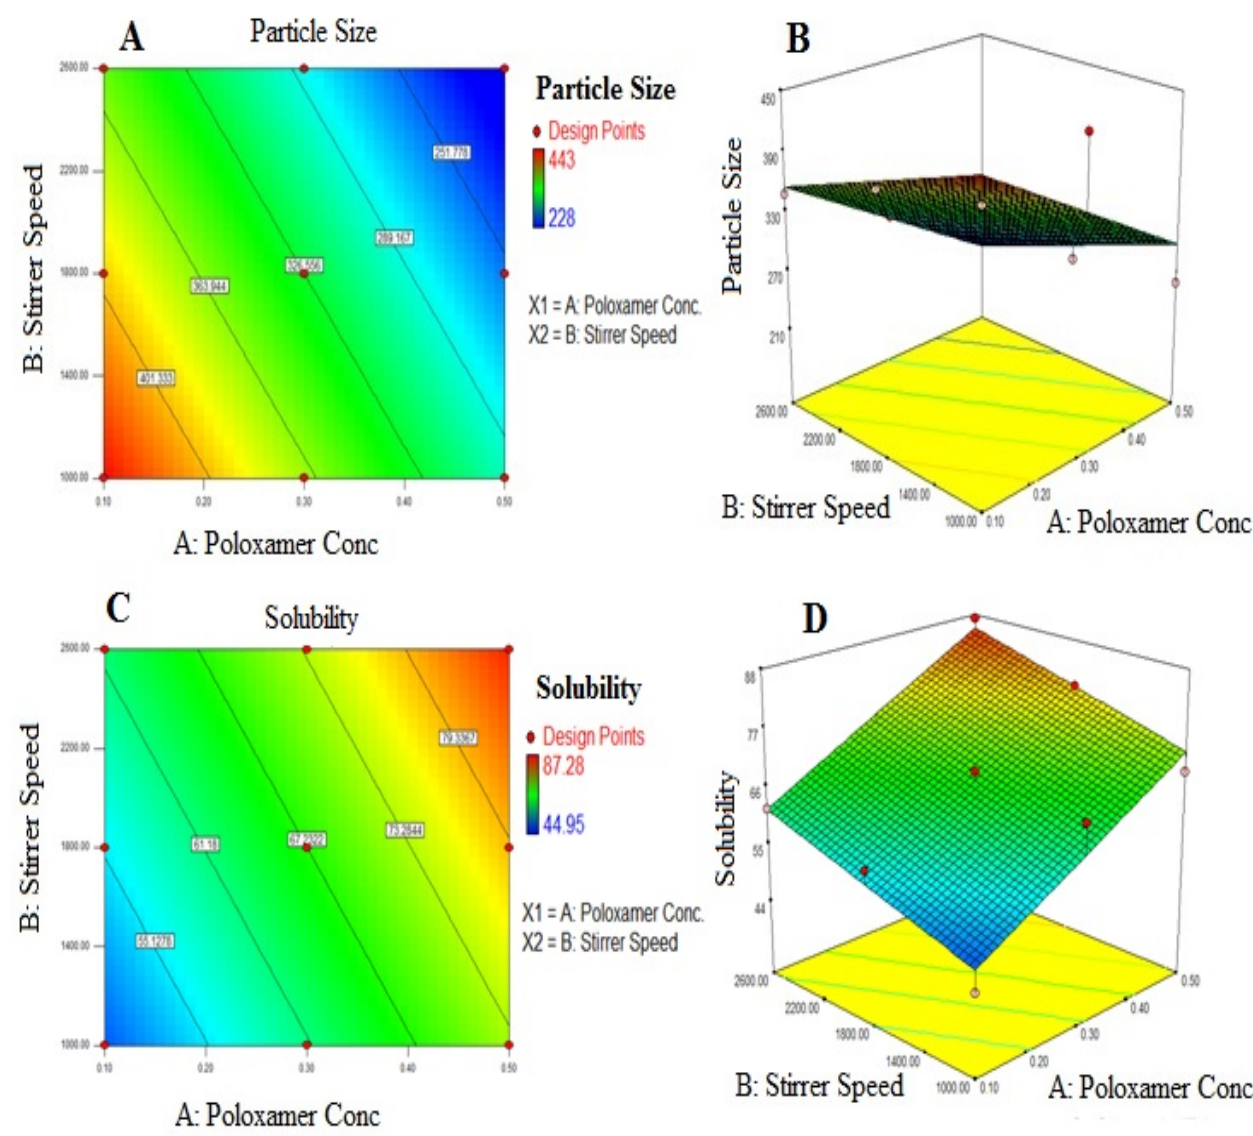
Figure 3. Linear and 3D response surface plot for independent variable’s effects on the response particle size ( A ) and ( B ), respectively, and on response solubility ( C ) and ( D ),